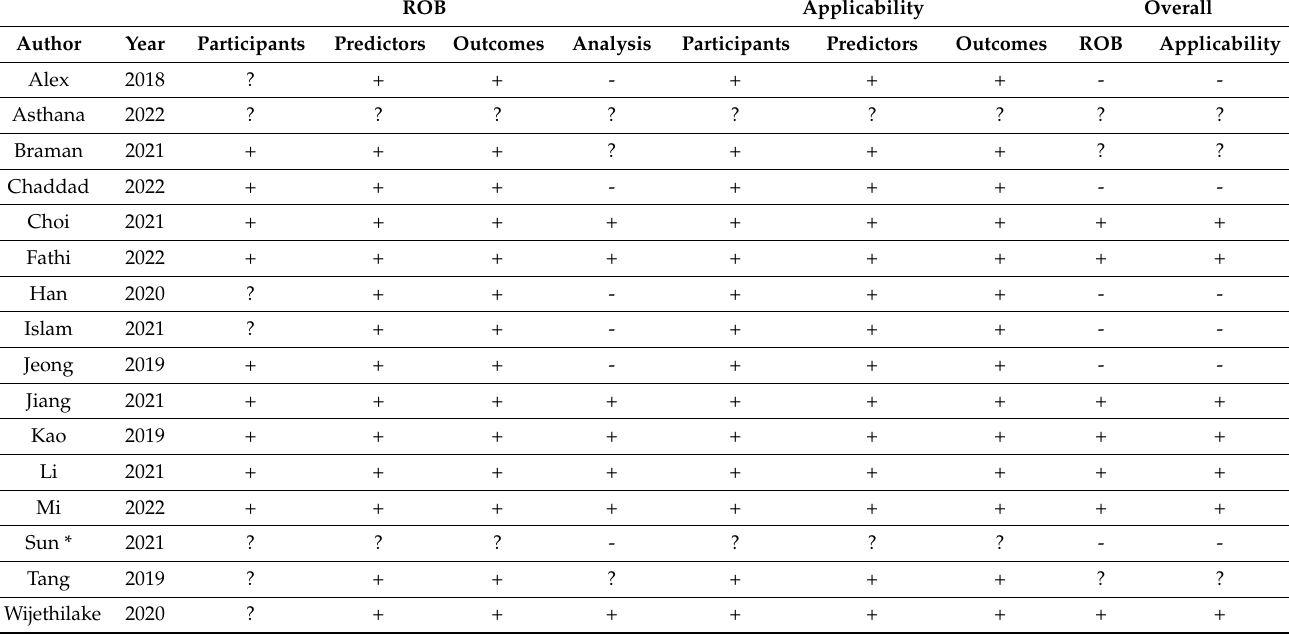
Table 2. Risk of